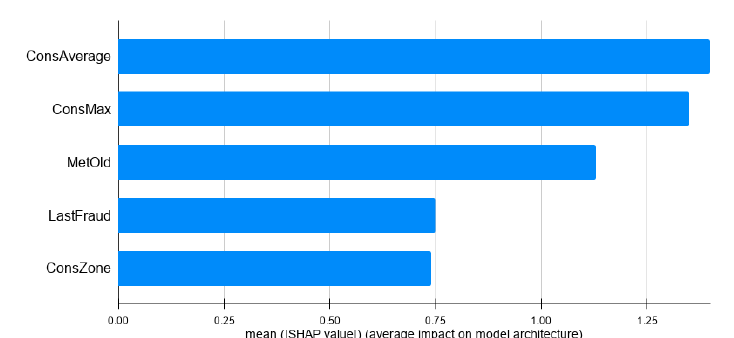
Figure 5. Mean absolute of SHAP values for the predictions of Campaign 1 using the Bypassing Meter model. The top 5 contributing features are: ConsAverage (represents the average consumption of the customer), ConsMax (maximum monthly consumption of the customer), MetOld (antiquity of the meter), LastFraud (months passed since last NTL case) and ConsZone (difference between the consumption of the customer vs. the average consumption in the